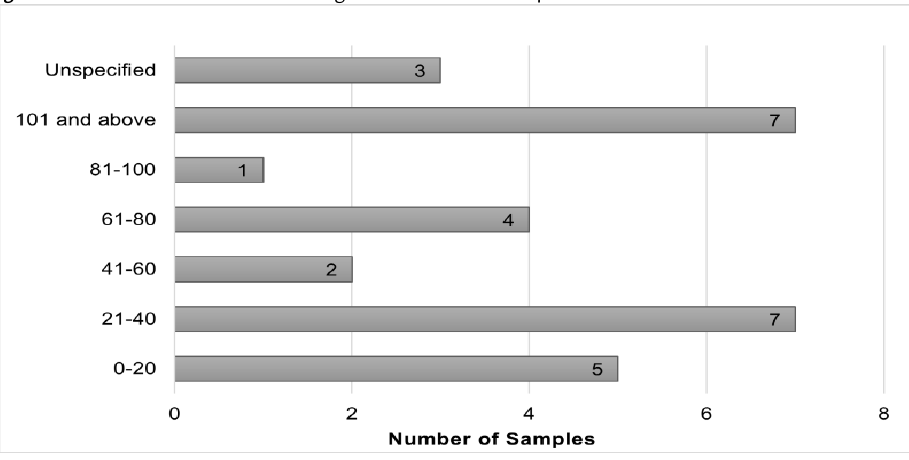
Figure 6: Distribution of Studies According to the Number of Samples